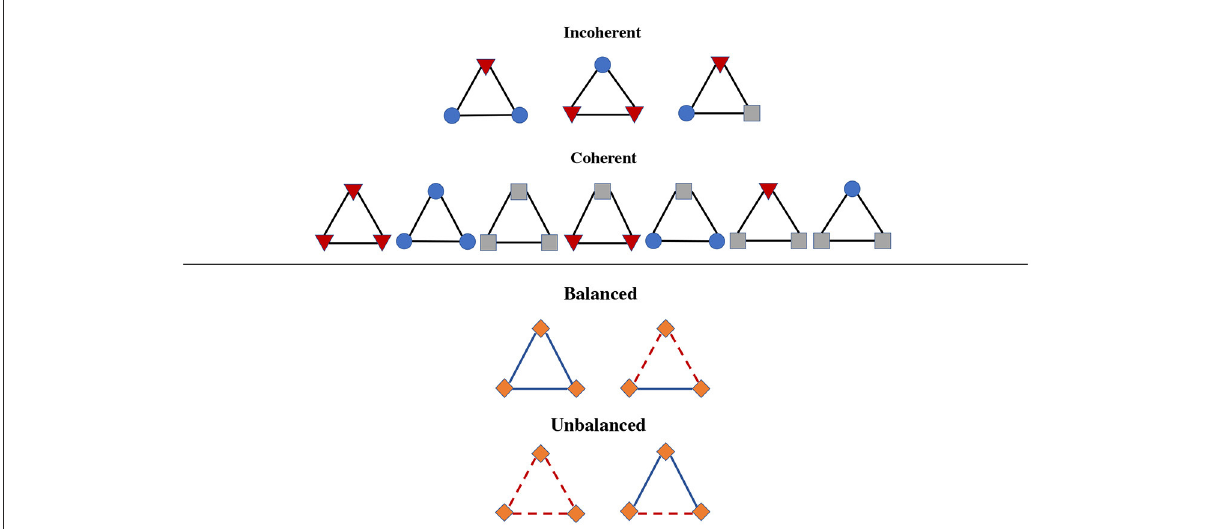
FIGURE1 Comparison of coherent/incoherent triads for measuring emotional complexity in word networks (Top) vs. balanced/unbalanced triads for measuring structural balance in social networks (Bottom) . Shapes indicate positive (circles), negative (triangles), or neutral (squares) words. Whereas, emotional coherence is based on nodes and words (incoherent triads do not mix words of opposite valence), structural balanced is based on positive and negative links,